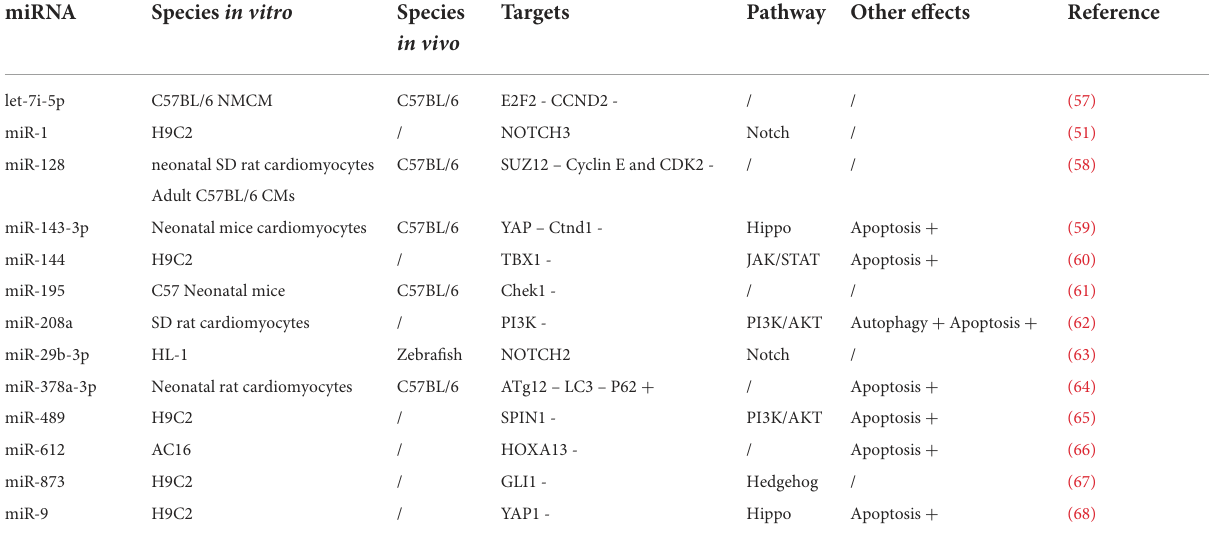
TABLE 2 A summary of the in vitro and in vivo effects of miRNAs on inhibited cardiomyocyte proliferation and the potential mechanism. miRNA Species in vitro Species in vivo